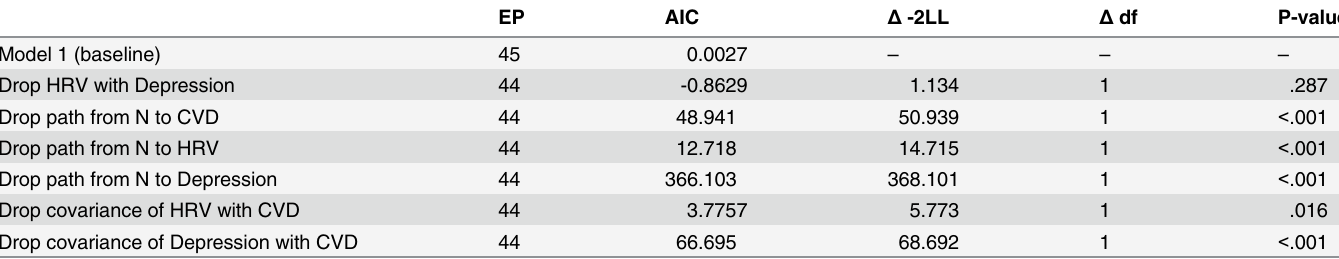
Table 3. Model comparisons: All paths significant by χ 2 and AIC comparison except for the HRV with Depression path.